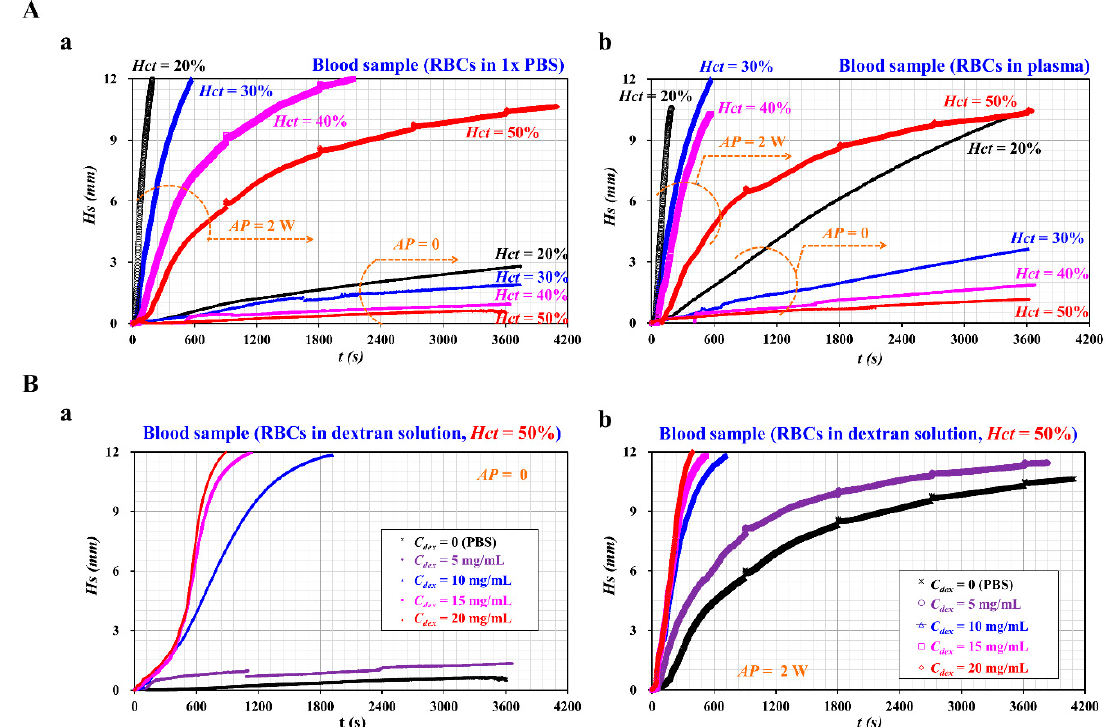
Figure 5. E ff ect of hematocrit and dextran solution on RBC-to-liquid separation. ( A ) Variations of Hs with respect to hematocrit ( Hct = 20%, 30%, 40%, and 50%) and base solution (1x PBS, plasma). ( a ) Temporal variations of Hs of blood sample (normal RBCs in 1x PBS) with respect to acoustic power and hematocrit. ( b ) Temporal variations of Hs of blood sample (normal RBCs in plasma, Hct = 50%) with respect to acoustic power and hematocrit. ( B ) Variations of Hs with respect to concentration of dextran solution ( C dex = 0, 5, 10, 15, and 20 mg / mL) and acoustic power (0, 2 W). ( a ) Temporal variations of Hs with respect to C dex and acoustic power = 0. ( b ) Temporal variations of Hs with respect to C dex and acoustic power = 2 W.